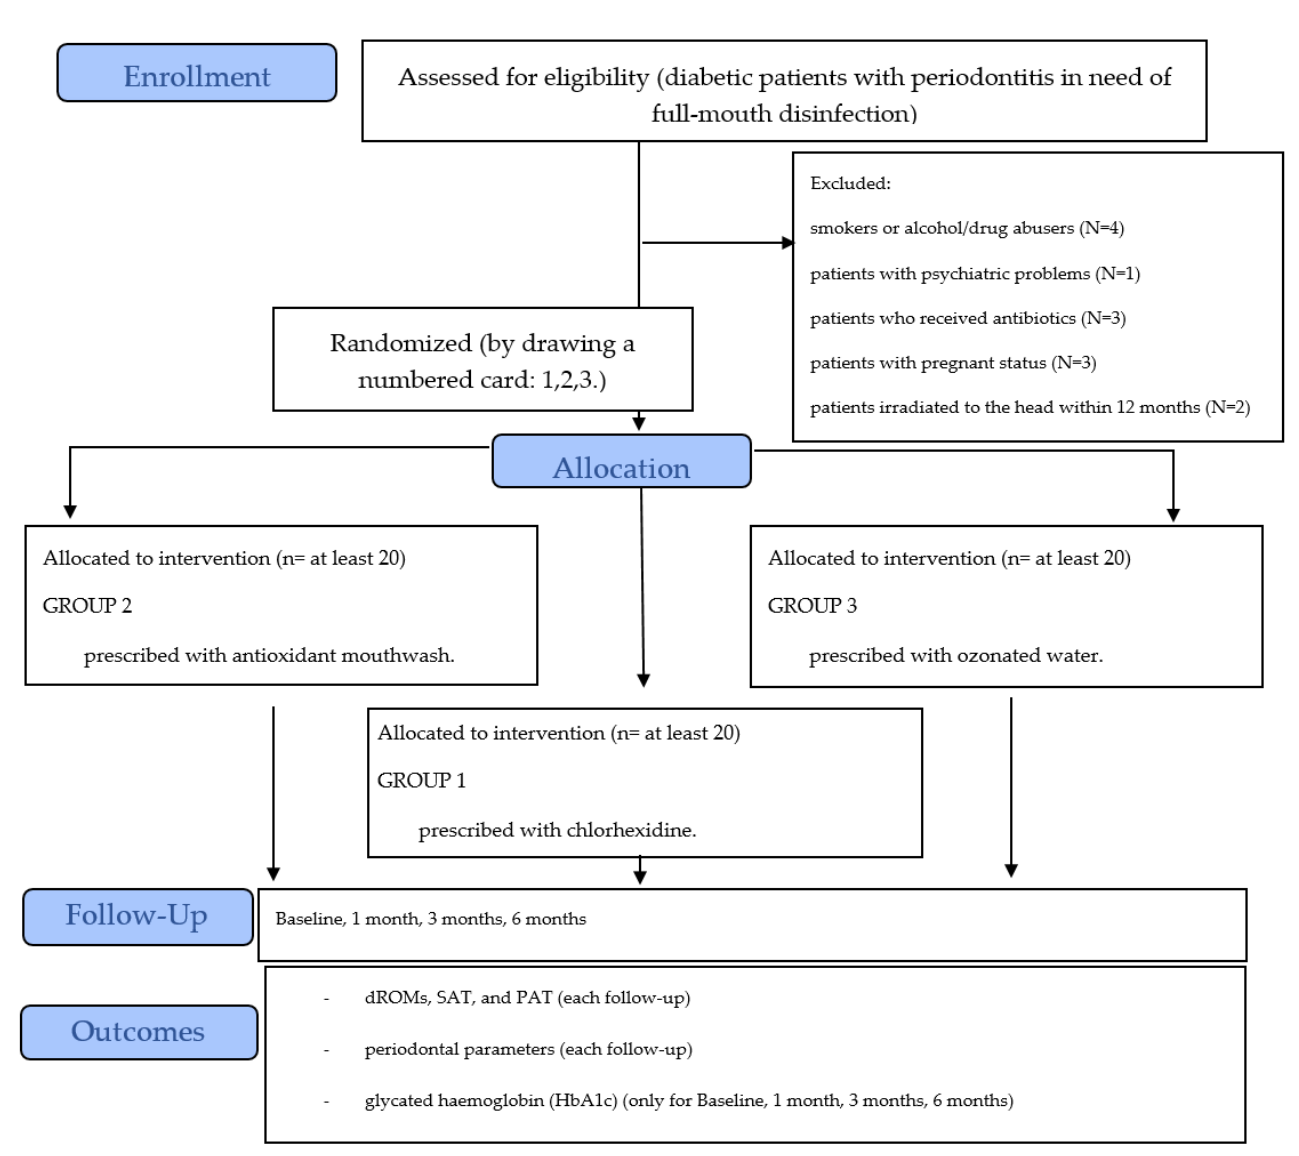
Figure 1. Subject recruitment and treatment allocation flow chart.